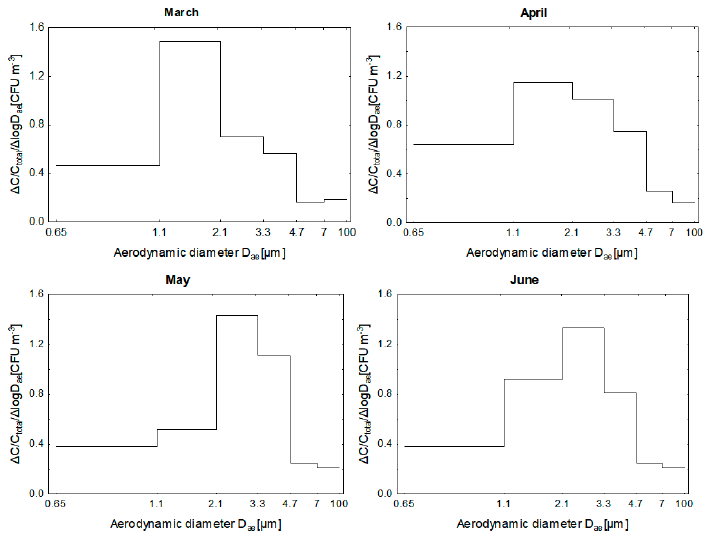
Figure 2. Size distribution of the bacterial aerosol in the offices indoor air. D ae —aerodynamic diameter; Δ C—concentration of bacterial aerosol on particular stage of 6-stage Andersen impactor; C total —total concentration of bacterial aerosol; Δ log D ae —logarithm of differences of cut-off diameters for particular stage of 6-stage Andersen Impactor.